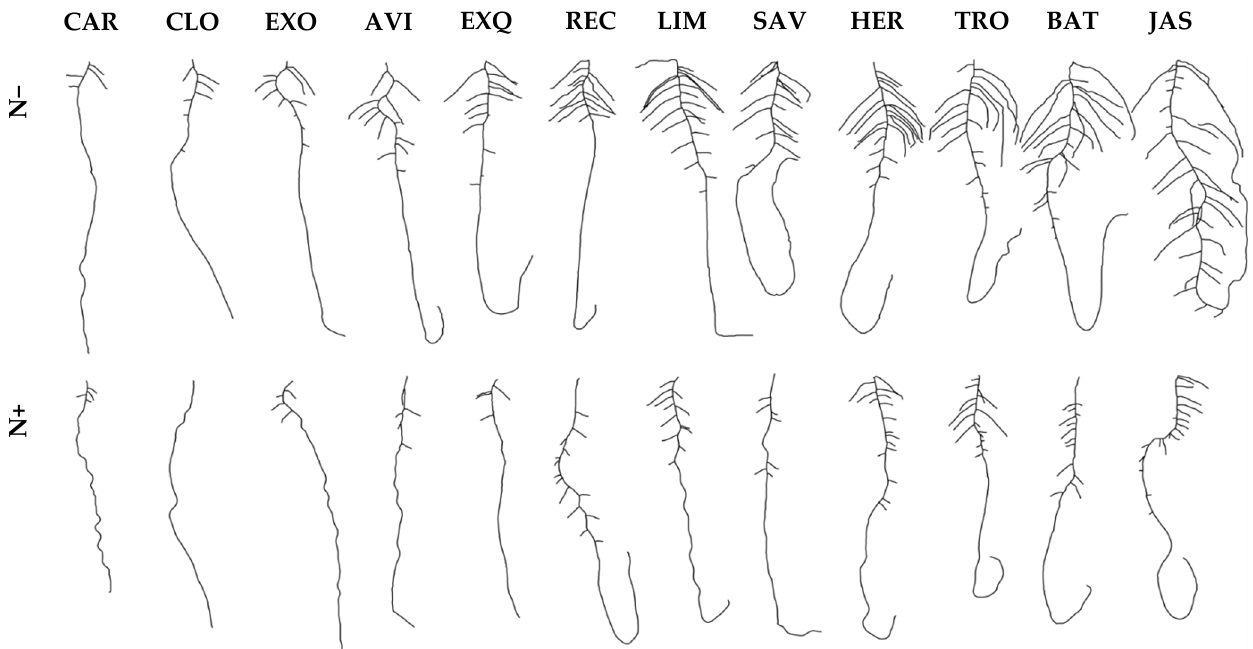
Figure 2. Root morphologies of oilseed rape cultivars grown in vitro with two divergent nitrate supplies. Pictures of representative root organs of 12 contrasting oilseed rape accessions grown with 0.01 mM (upper row, N − ) or 10 mM (lower row, N+) nitrate supplies. Accessions are ranked from the left to the right by increasing total root length (TLR) measured at N − . The TRL values were ranging between 12.1 ± 0.9 cm (CAR) and 41.5 ± 2.9 cm (JAS). Cultivar full names are listed in Table S1. Scale bar: 2 cm.